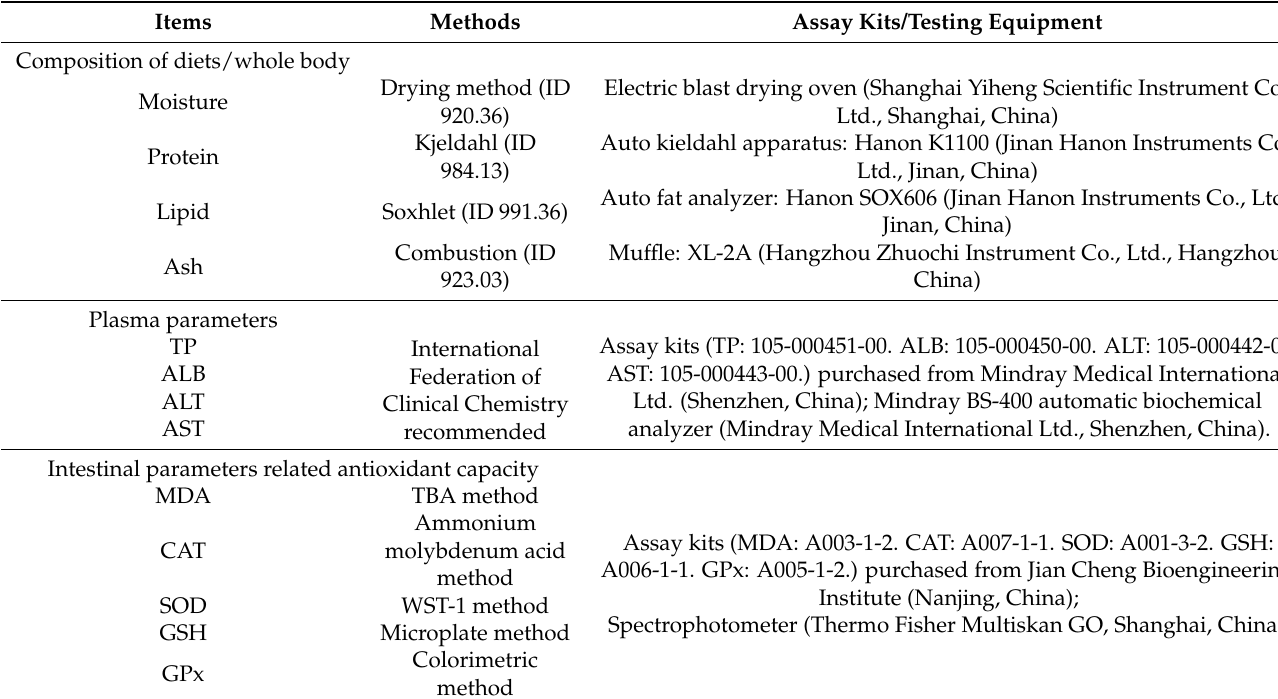
Table 2. The chemical analysis used in the